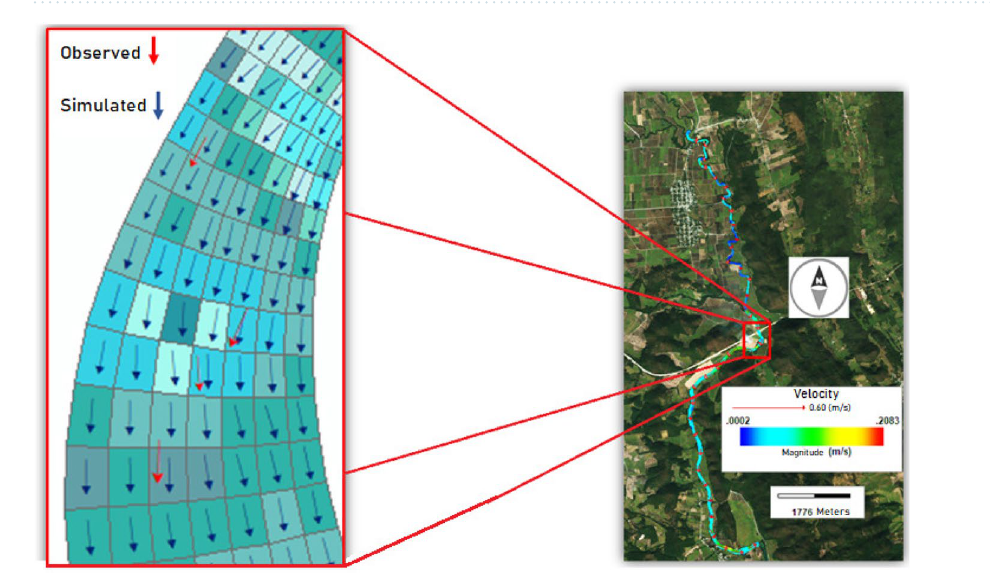
Figure 8. Velocity field, acquired data (circle) vs simulated data (dashed lines), for a small period of time. To calculate RMSE all the time serie was used (dry season: RMSE = 0.007; wet season: RMSE = 0.002).